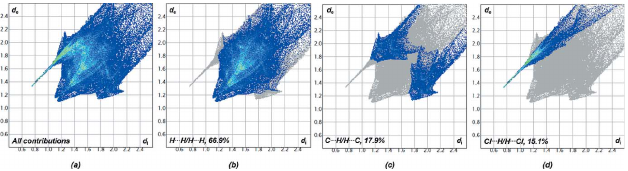
Figure 4 Two-dimensional fingerprint plots of compound 1 showing close contacts of ( a ) all contributions in the crystal and those delineated into ( b ) H (cid:2)(cid:2)(cid:2) H, ( c ) C (cid:2)(cid:2)(cid:2) H/H (cid:2)(cid:2)(cid:2) C and ( d ) Cl (cid:2)(cid:2)(cid:2) H/H (cid:2)(cid:2)(cid:2) Cl-interactions. Symmetry codes: (i)